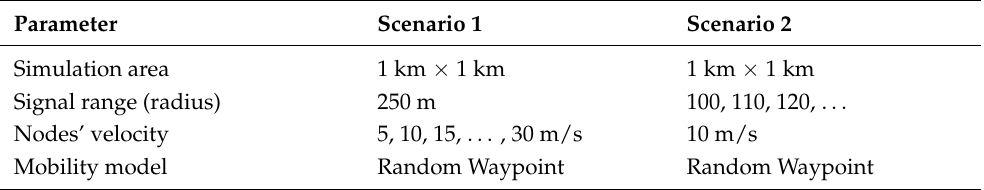
Table 1. The settings of the two implemented scenarios of the mathematical model parameters.